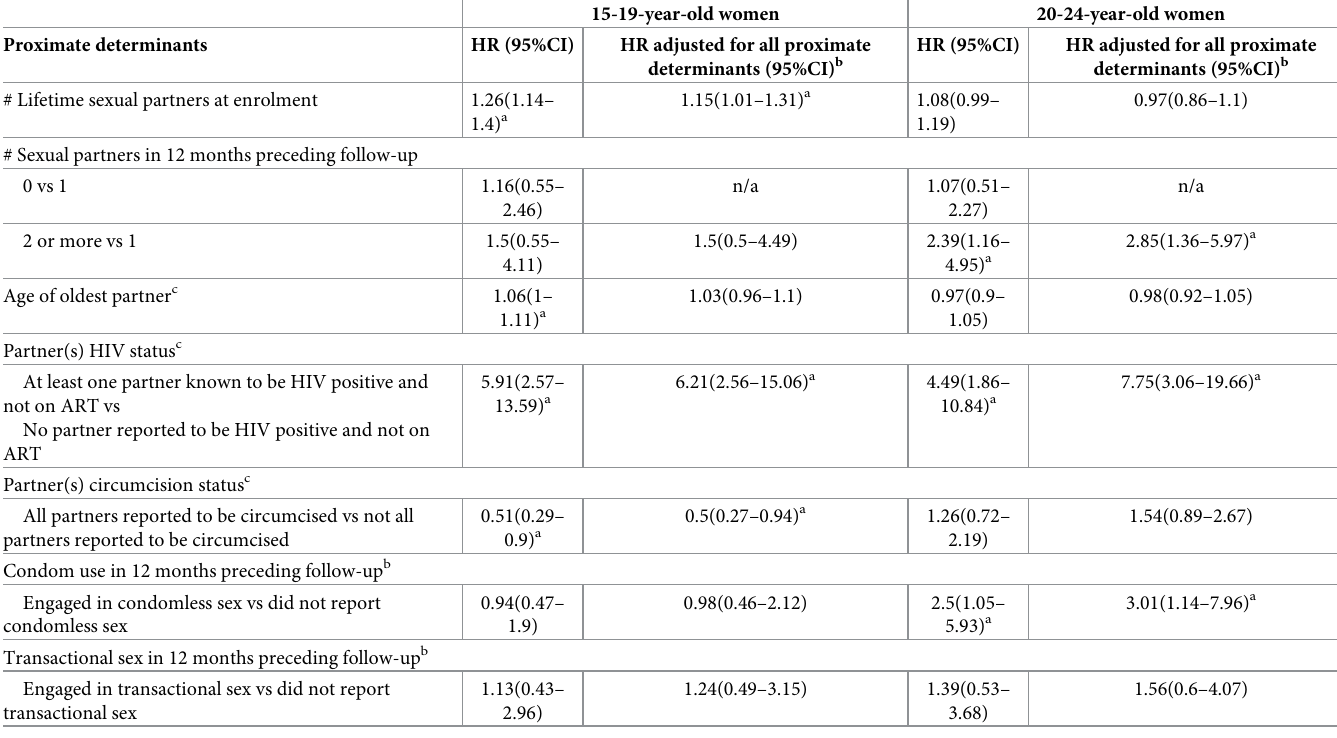
Table 2. Association between proximate determinants and HIV incidence in adolescent girls and young women enrolled in the HIPSS